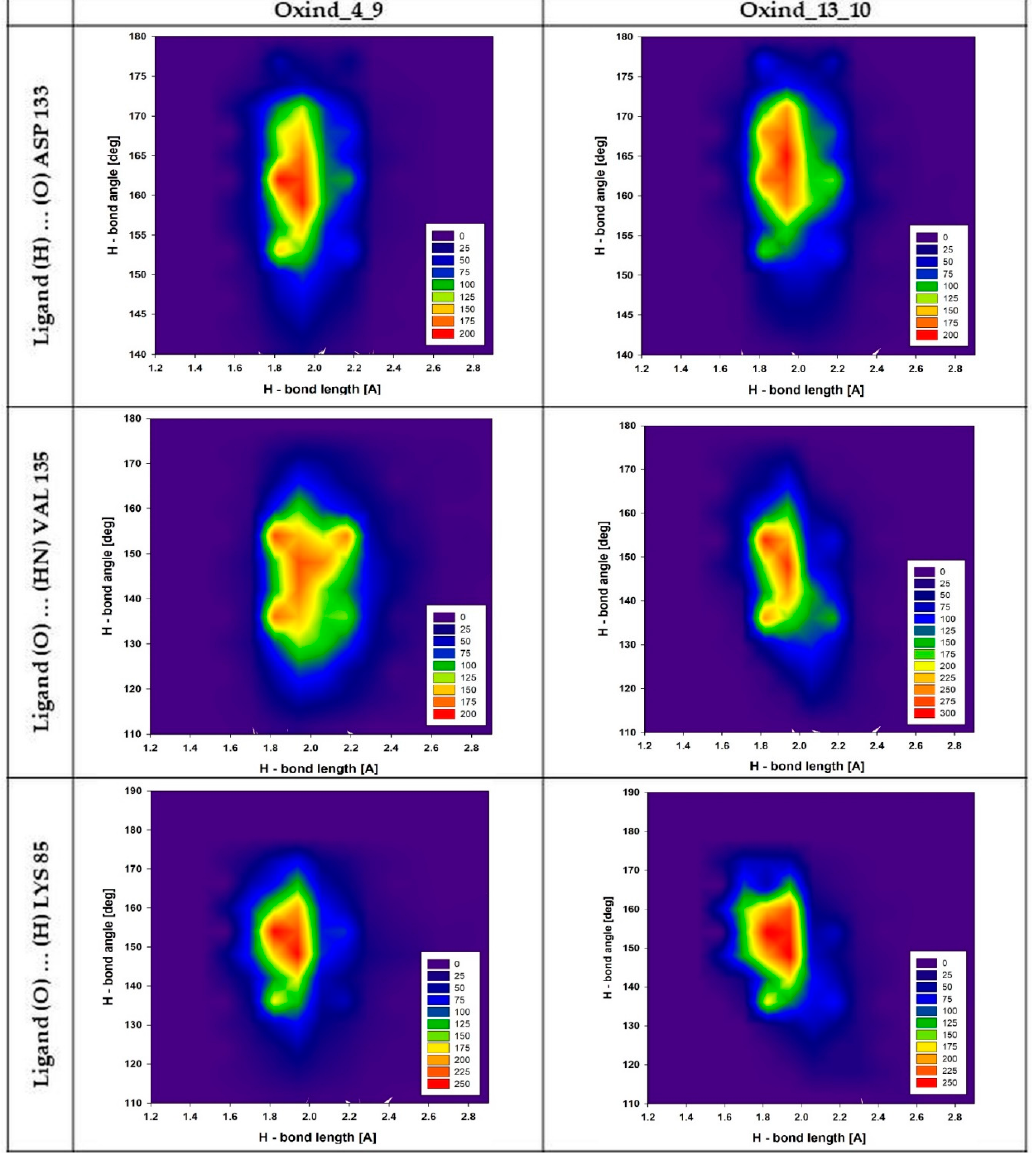
Figure 4. Distributions presenting mutual dependencies between values of angles and lengths characterizing hydrogen bonds created by Oxind_4_9 and Oxind_13_10 molecules with chosen amino acids from the GSK-3 β active site. The headings of the individual columns define the name of the ligand, while the line descriptions define the hydrogen bond under consideration.